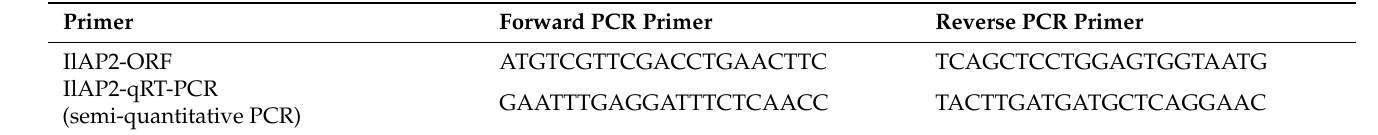
Table 1. Primer sequences of the genes for full-length open reading frames (ORFs) and semi- quantitative PCR and quantitative real-time